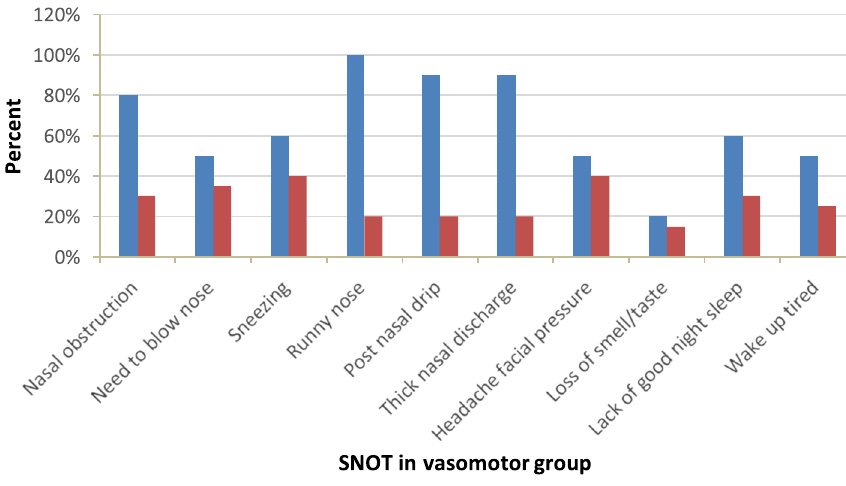
Fig. 3 Comparison between the pre- and post-SNOT questionnaire of symptoms among vasomotor